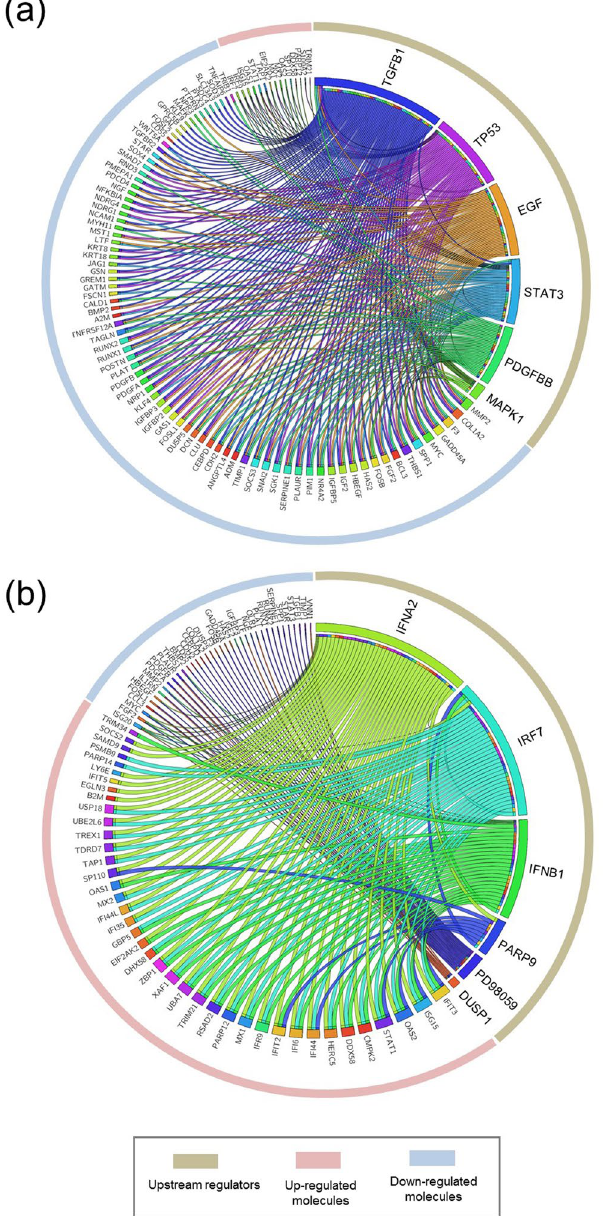
Figure 3. Upstream regulator analysis of FSH-priming-sensitive transcripts in cumulus cells. Ingenuity Pathway Analysis was used for the prediction of upstream molecules including cytokines, growth factors, transcription factors and chemicals. Selected upstream molecules, from the top 30, whose predicted activation status was “inhibited” ( a ) or “activated” ( b ) with corresponding molecules are shown. Inhibited and activated upstream molecules were defined as an activation z-score ≤ − 1.5 and − log(P-value) > 1, and as an activation z-score ≥ 1.5 and − log(p-value) > 1, respectively. The upstream molecules were ranked by their − log(p-value). The significance was defined as − log(p-value) > 1. Brown, pink, and blue lines indicate upstream regulators, and up-regulated and down-regulated genes stimulated by each upstream molecule,